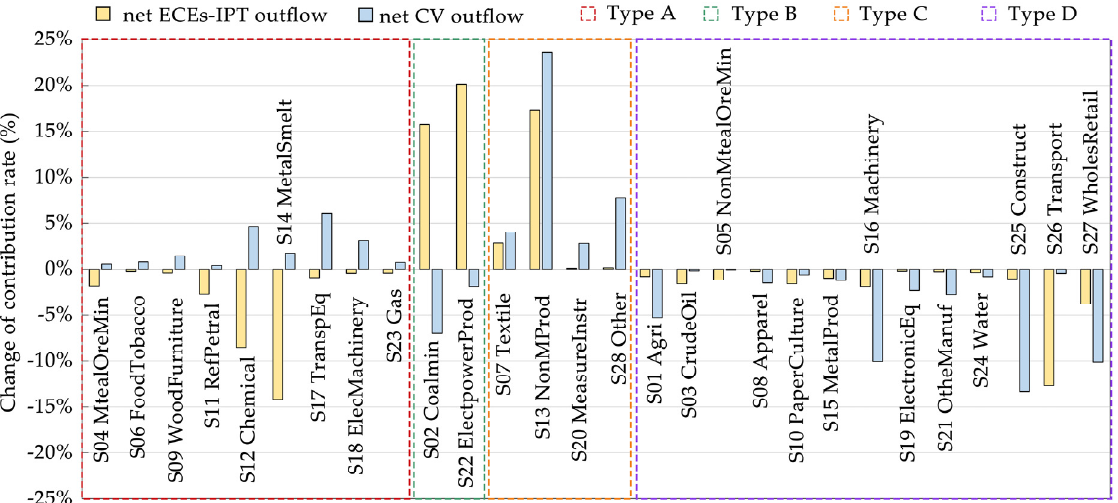
Figure 8. Contribution rate change of net CV outflow and net ECEs − IPT outflow of each industry sector in Anhui among the YREB from 2007 to 2017.